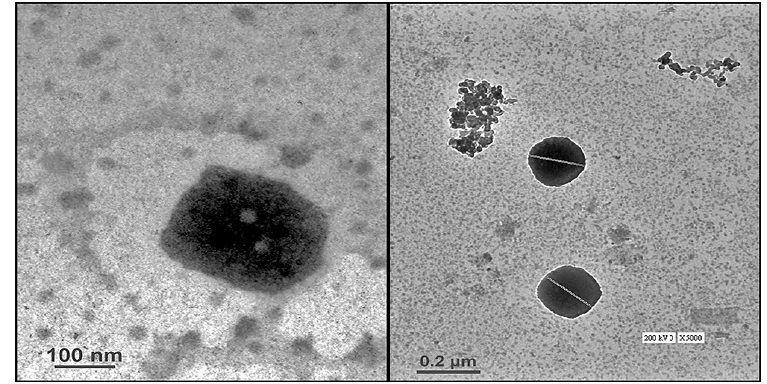
Figure 3. HR-TEM micrograph of Ros-LCNPs.